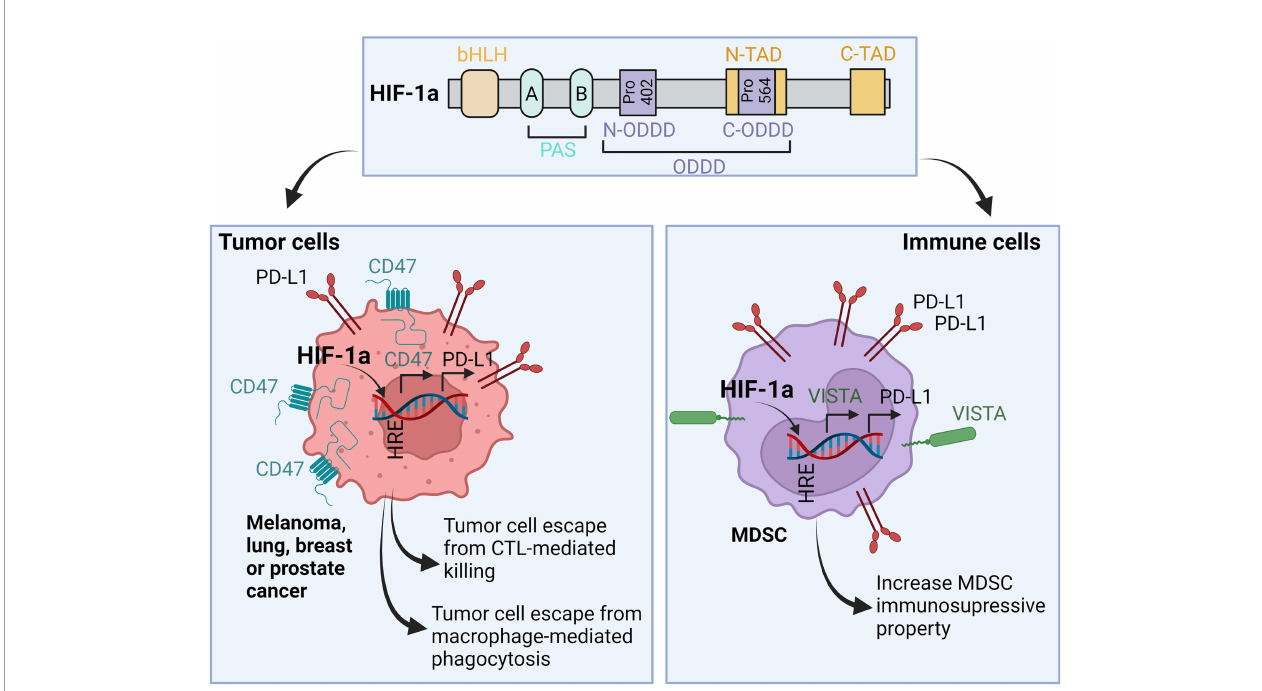
FIGURE 4 | Role of HIF-1 a in the regulation of immune checkpoints expression in both tumor and immune cells. In hypoxic microenvironment, HIF-1 a binds to the HRE motifs found in the promoters of PD-L1, CD47 and VISTA. As a result, HIF-1 a -depenedent overexpression of PD-L1 and CD47 in tumor cells leads to tumor escape from CTL-mediated killing and macrophage-mediated phagocytosis, respectively. In MDSC, HIF-1 a -dependent upregulation of PD-L1 and VISTA increases their immunosuppressive properties in the tumor microenvironment. bHLH, basic-helix-loop-helix; PAS, Per-Arnt-Sim domains; Pro, Proline residue; N- and C-ODDD, NH 2 -terminal and COOH-terminal Oxygen-Dependent Degradation Domains; N- and C-TAD, NH 2 -terminal and COOH-terminal transactivation